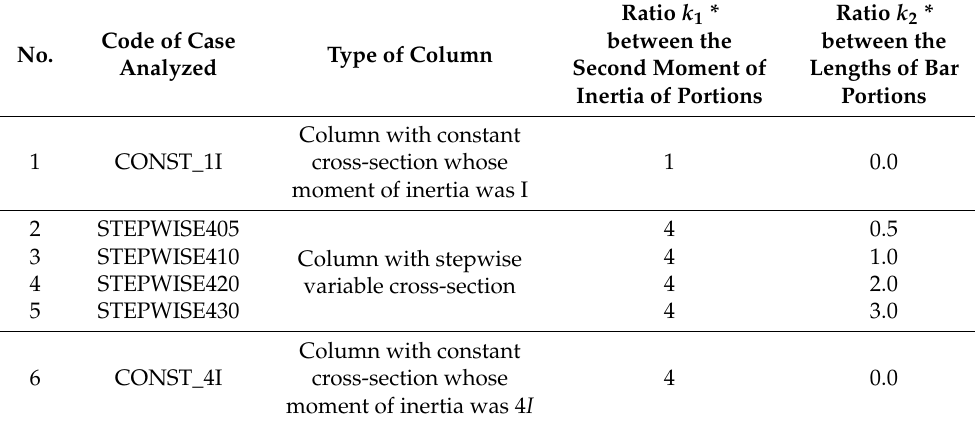
bility loss. Table 2. Values of the ratios k 1 and k 2 considered for the analyzed cases with the FEM for bars with pin connections at one end and simple supports at the other